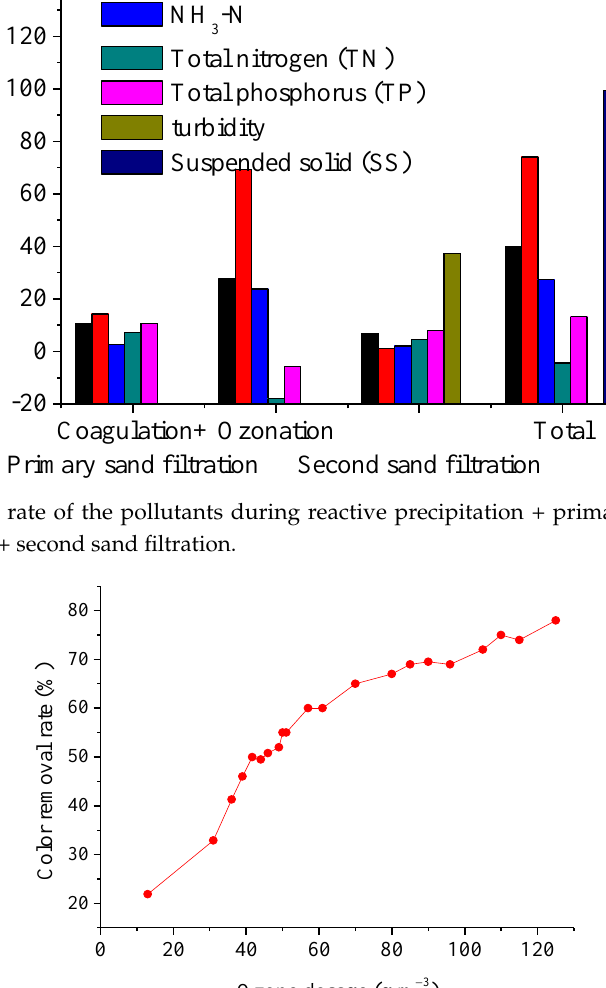
Figure 4. Removal rate of the NH 3 -N, TP, and TN in primary ozonation .